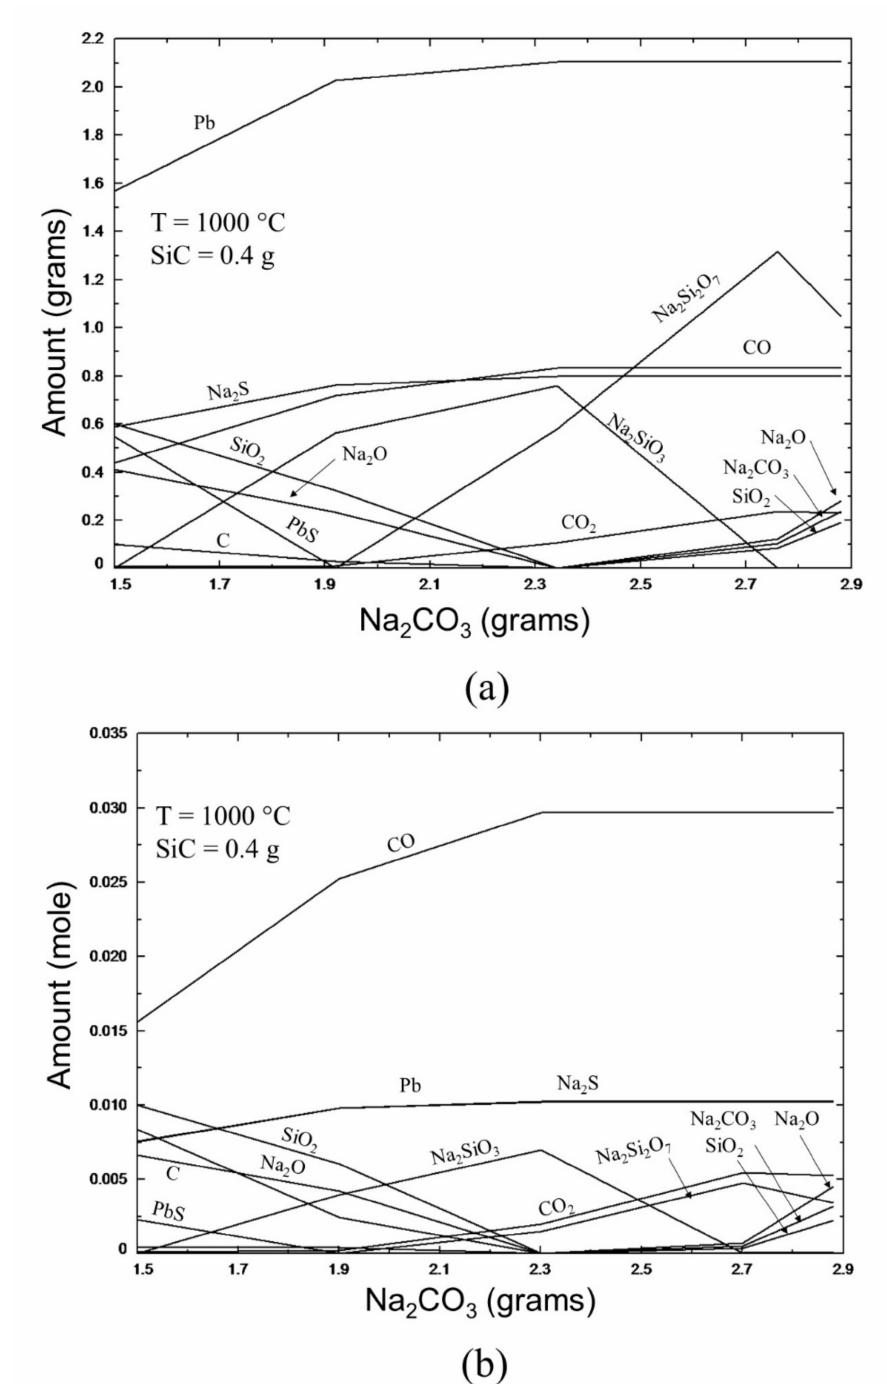
Figure 10. Thermodynamic analysis for products metal and slag, ( a ) in grams and ( b ) in mole, when 2.45 g PbS, 40% of Na 2 CO 3 by weight (2.88 g), related to 4 g of lead concentrate and 0.4 g of SiC are used in the initial charge to 1000 ◦